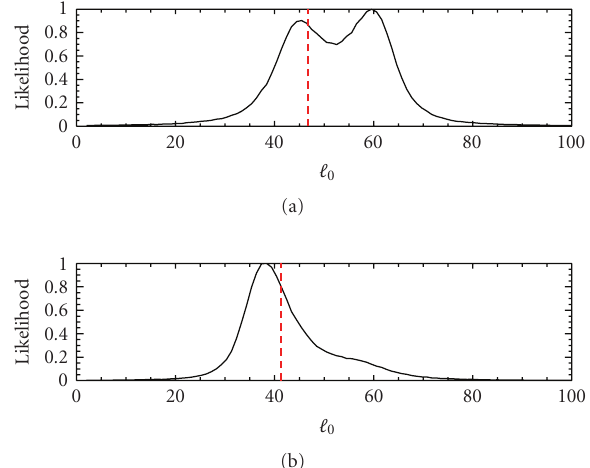
Figure 3: These plots show the results of the calculation of (cid:2) 0 for the polynomial fitting routine. The top plot is for the unbinned data, and the bottom plot is for the binned